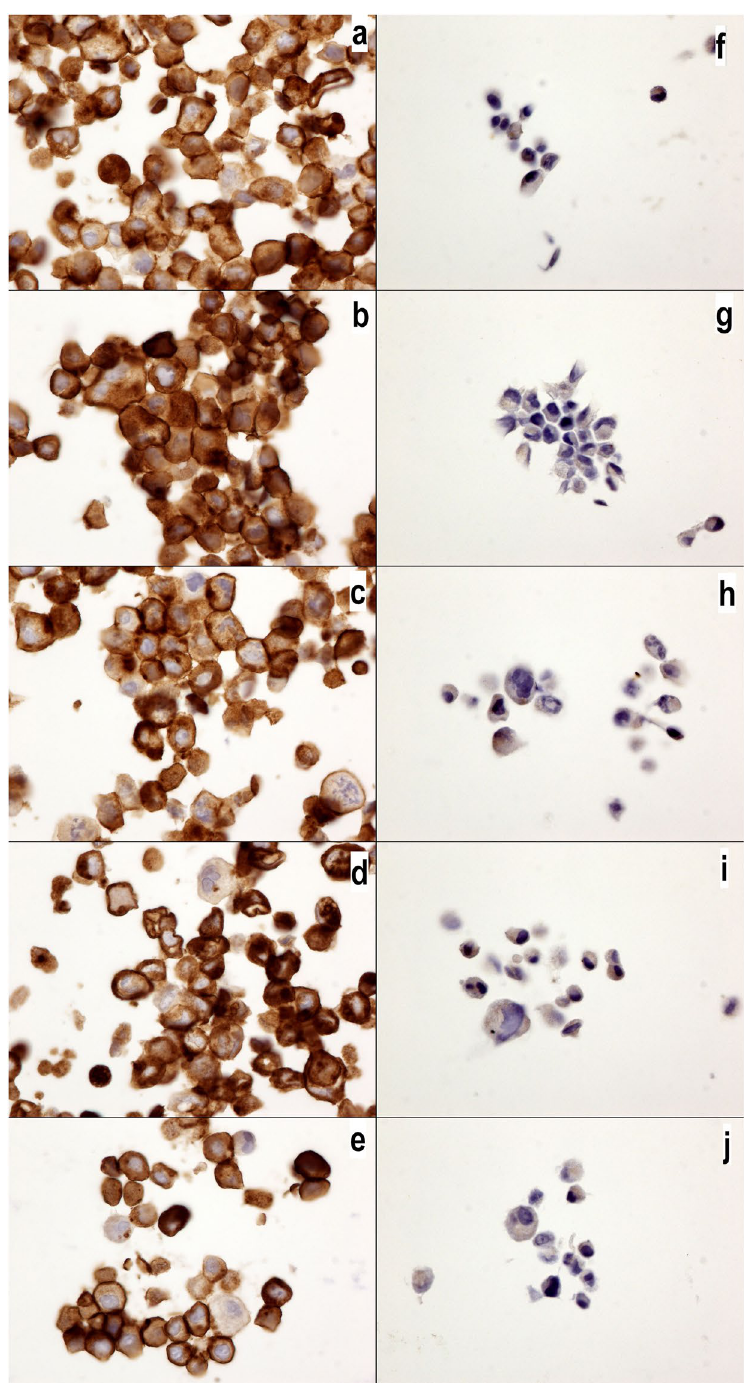
Figure 4. MUC1-C expression in MCF7 and MDA-MB231 cells. MUC1-C expression in MCF7 ( a – e ) and MDA-MB231 cells ( f – j ) without drugs or ( a , f ) with cyclophosphamide ( b , g ), doxorubicin ( c , h ), epirubicin ( d , i ) or 5-fluorouracil ( e , j ). Note the higher expression of MUC1-C in the MCF7 cells than that in the MDA-MB231 cells, but no changes were observed with the chemotherapy drug treatments. The MUC1-C antibody was diluted 1/400 (40x